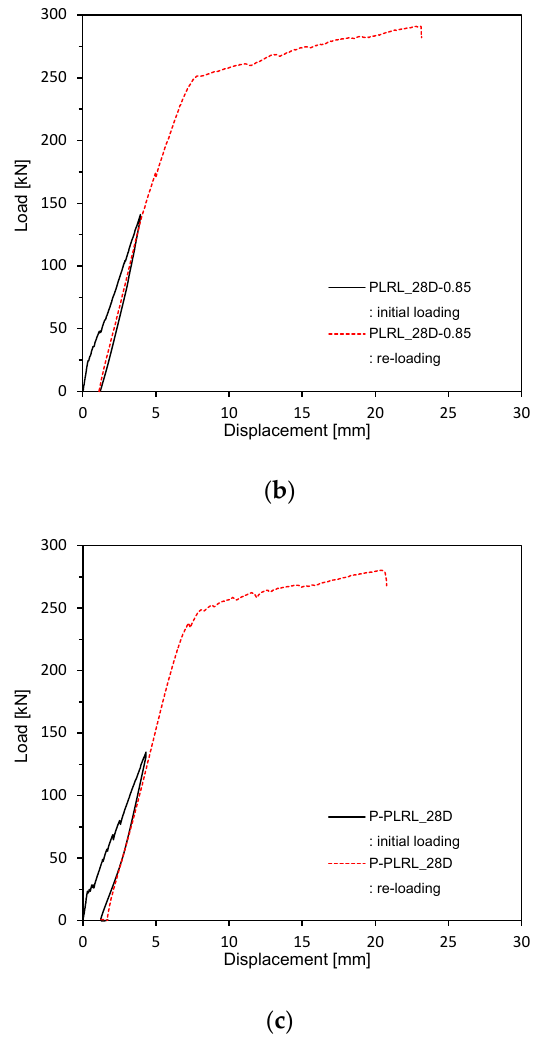
Figure 11. Load-deflection measurement after 28 days (up to ultimate load after pre-loading): ( a ) 2.5 series; ( b ) 0.85 series; ( c ) Plain series.